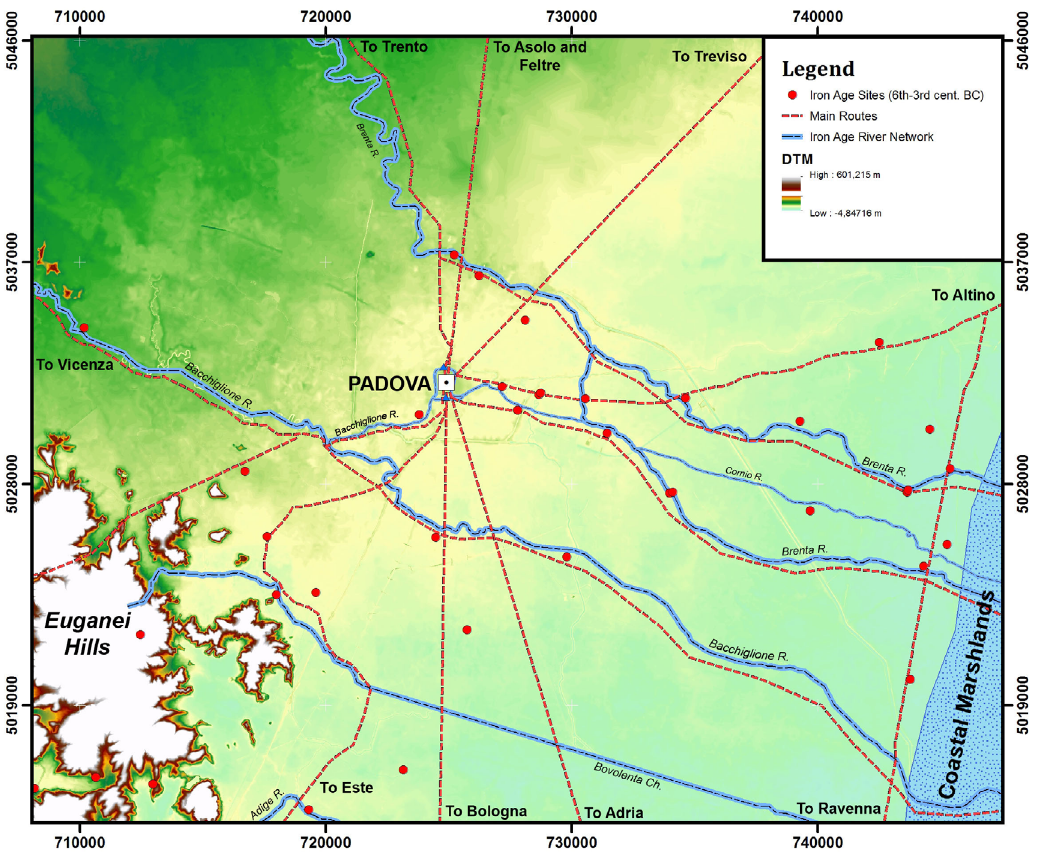
Fig. 8 The main routes reaching Padua during late Iron